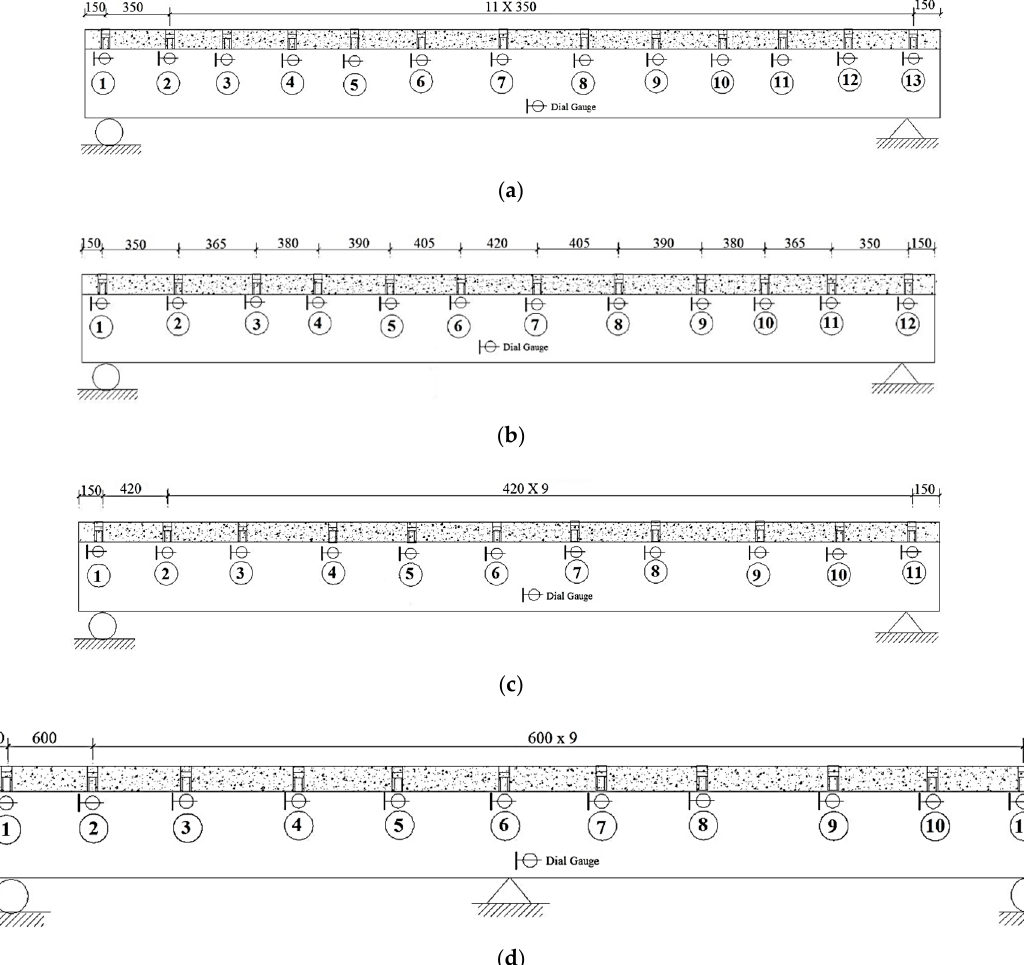
Figure 4. Location of dial gauges (mm); ( a ) SPB1; ( b ) SPB2; ( c ) SPB3; ( d ) ECB-1 and ECB-2.